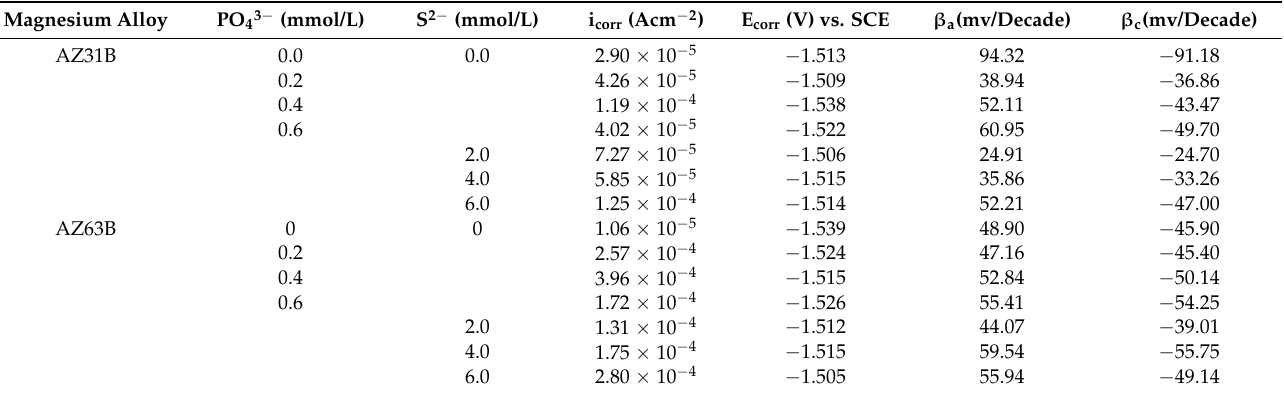
Table 6. Potential polarisation curve parameters for magnesium alloy immersed in different solutions for 14